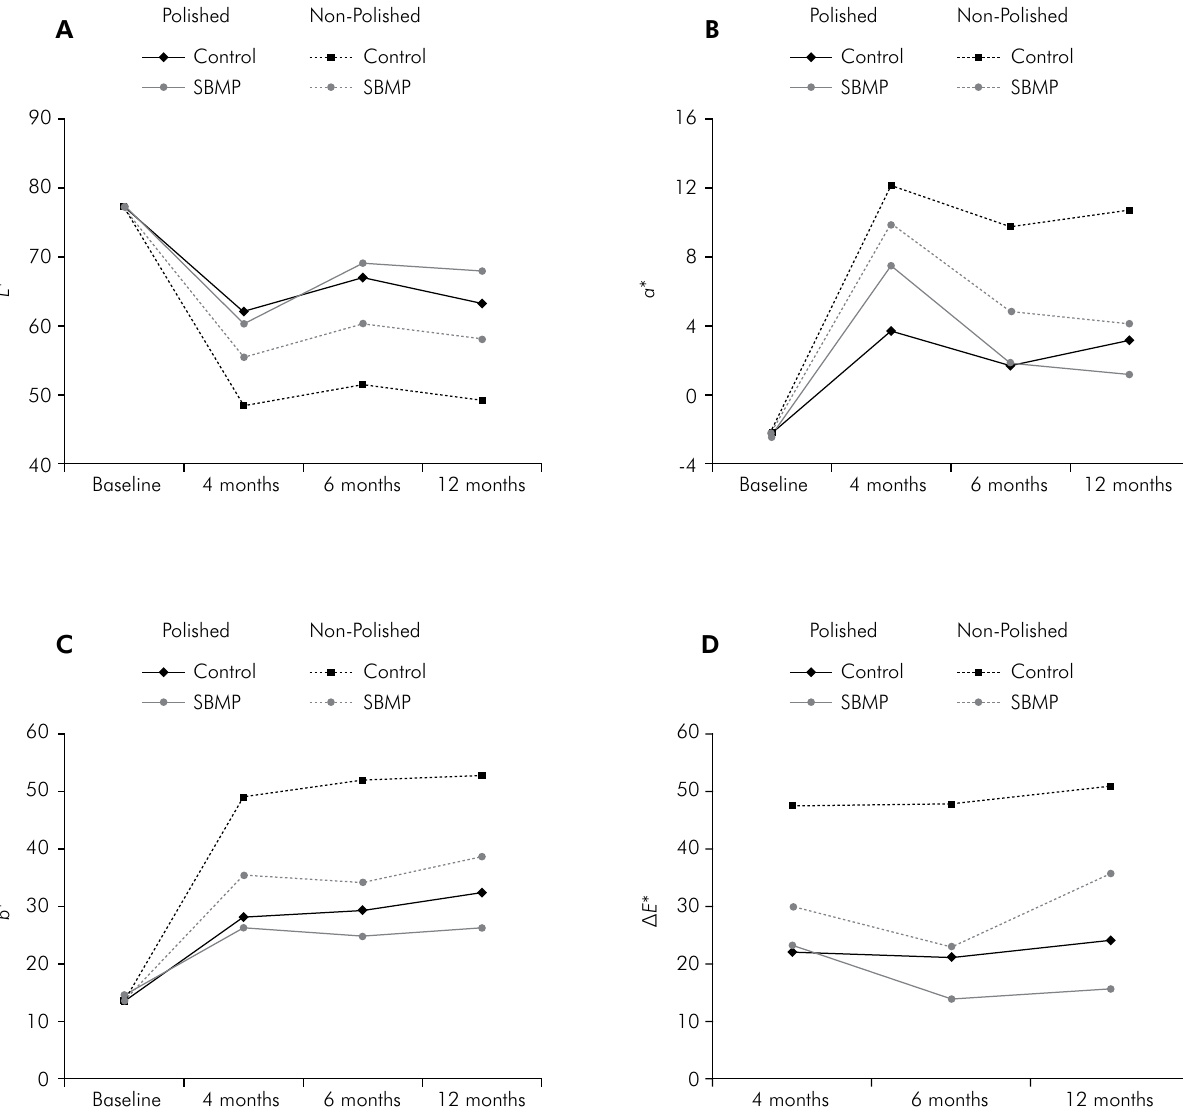
Figure 1. Color parameters tested in the study for the polished and non-polished specimens, with (SBMP) or without (control) application of modeling liquid: L * (a), a * (b), b * (c), and color change/Δ E *